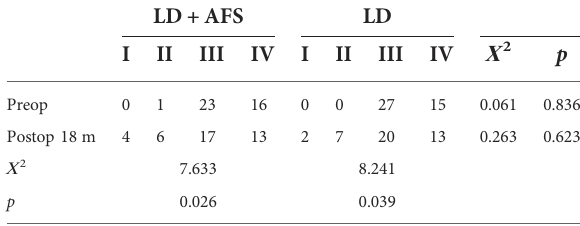
TABLE 3 Modi fi ed P fi rrmann grade of disc degeneration in the two